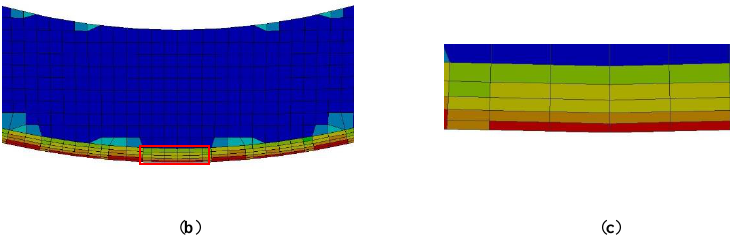
Figure 7. Numerical model of profiling constrained flow passage for titanium alloy complex surface: ( a ) orthogonal view; ( b ) local enlarged view; and ( c ) local enlarged view of a region.